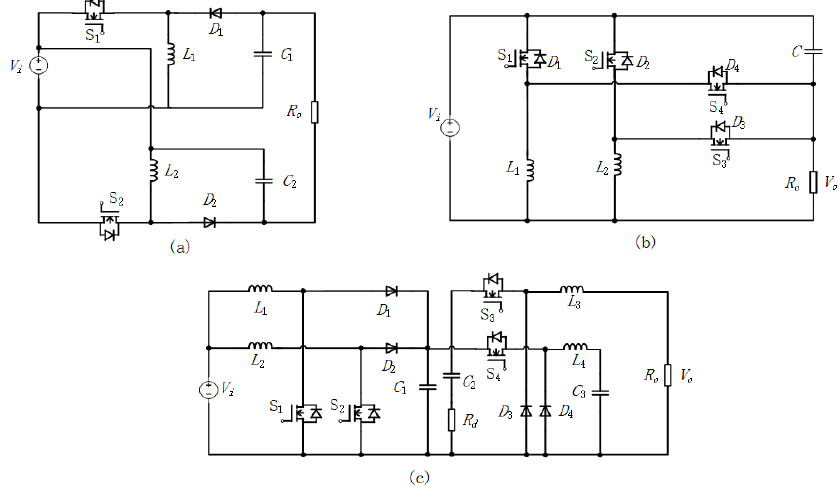
Figure 25. Interleaved buck-boost DC-DC converters. ( a ) [51]. ( b ) [52]. ( c ) [53].